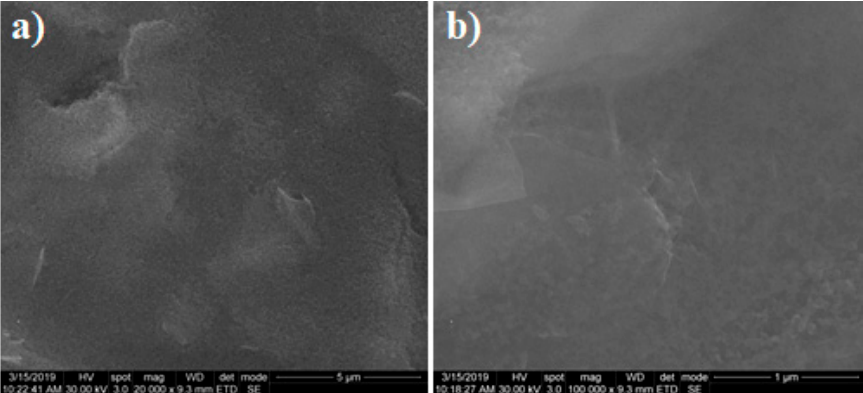
Figure 2. SEM images of reduced graphene oxide (RGO)-modified SPCE using 0.15 mg/mL dispersion recorded at ( a ) 20 kX and ( b ) 100 kX magnifications.